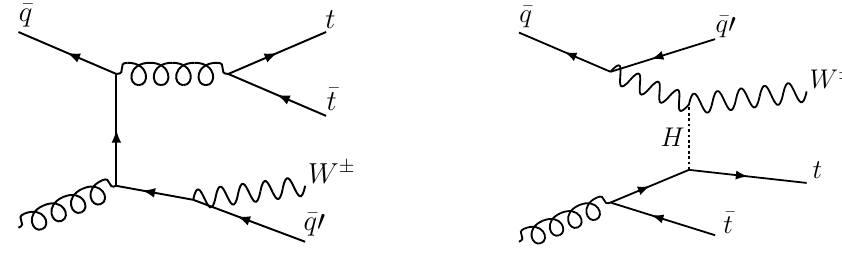
Figure 2 . Representative diagrams for the (cid:22) qg ! t (cid:22) tW (cid:6) (cid:22) q 0 real-emission amplitudes. The left diagram is of O ( (cid:11) 3 = 2 s (cid:11) 1 = 2 ) and leads to log 2 ( p 2 right one is of O ( (cid:11) 1 = 2 s (cid:11) 3 = 2 ), involves the tW ! tW scattering and contributes to the NLO 3